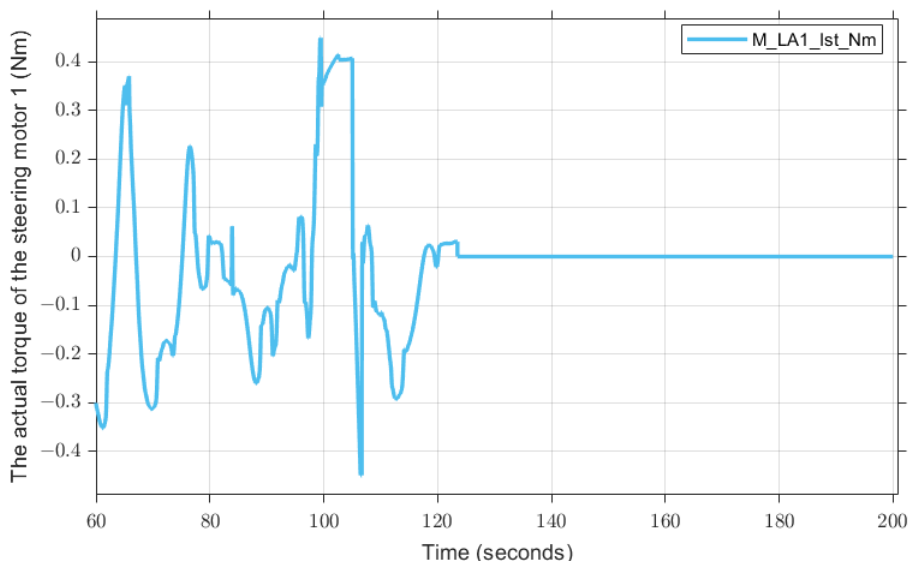
Figure 28. Actual steering torque of the steering motor 1, which fails at 123.5